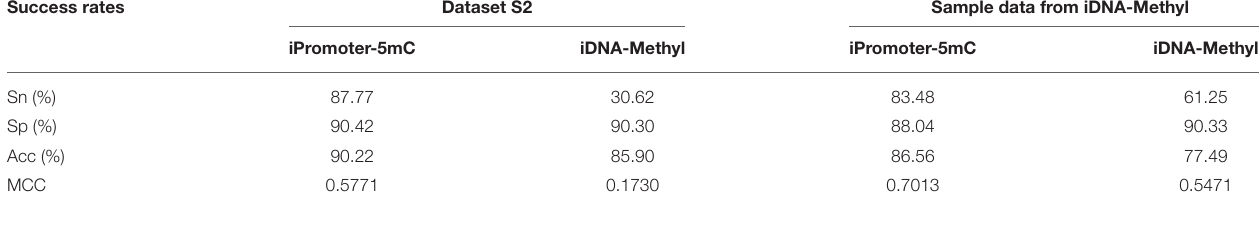
TABLE 5 | Comparison of predictors’ performance on the independent testing dataset S 2 and sample data from iDNA-Methyl by 5-fold cross validation, respectively.